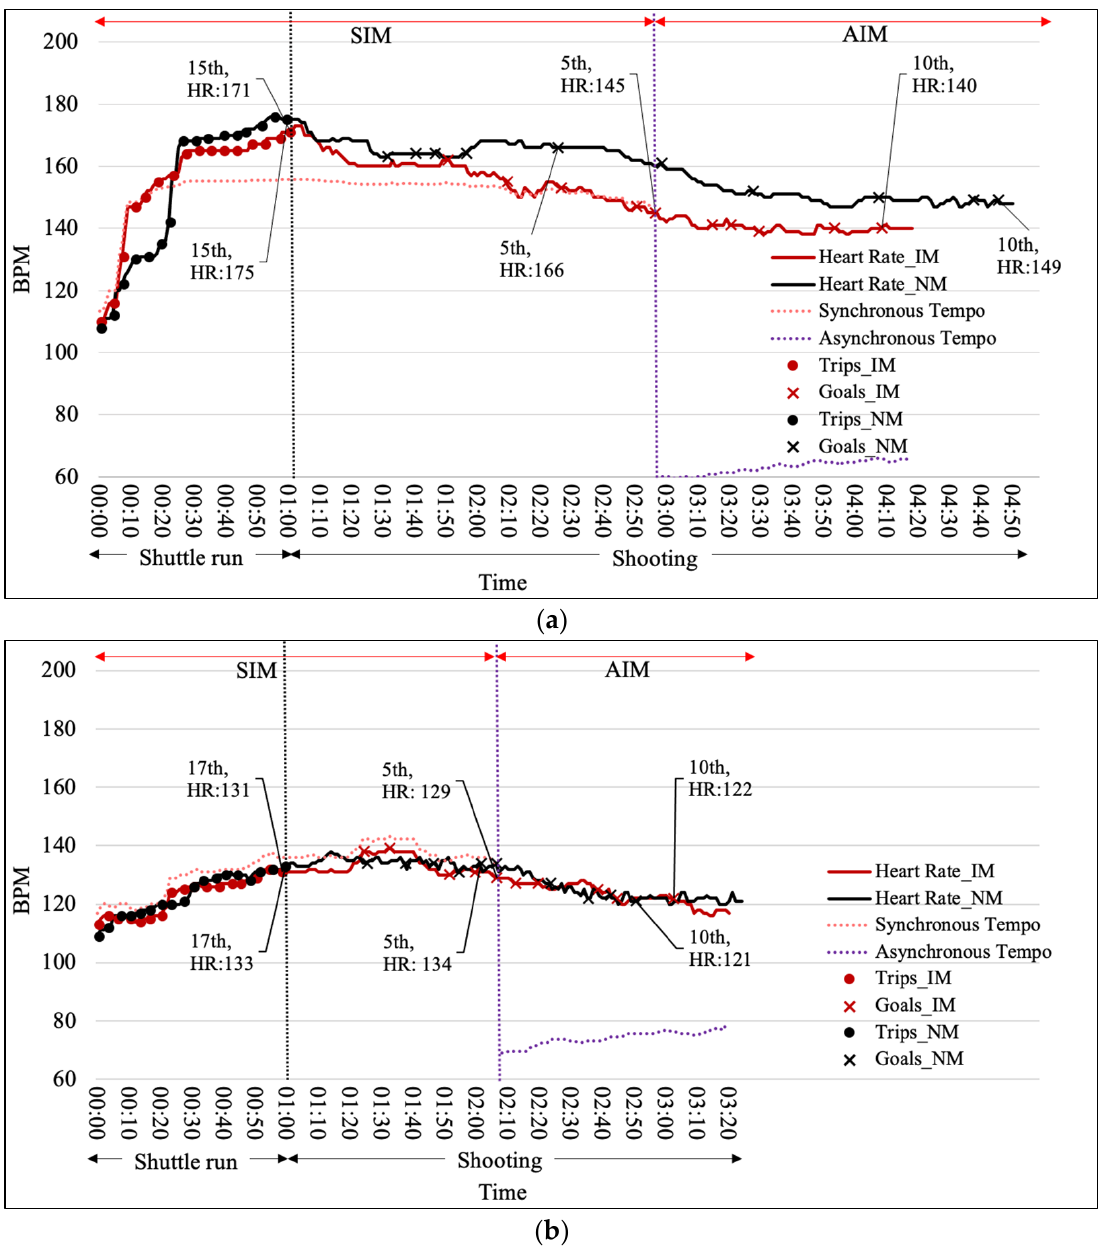
Figure 7. Heart Rate Response during the tasks with IM and NM conditions ( a ) could be clearly observed ( b ) could not be clearly observed.